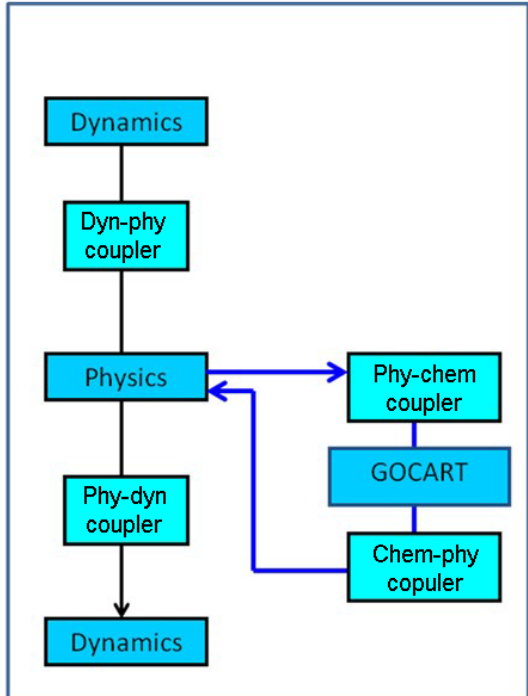
Figure 3. Primary integration runstream of